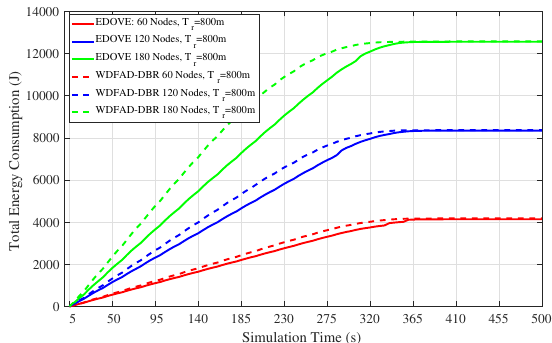
Figure 10. Total network energy consumption during the simulation duration for fixed transmission range of 800 m and varying number of nodes in the network.